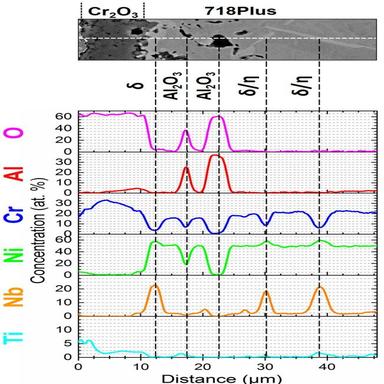
EDXS concentration vs. depth profiles of O, Al, Cr, Ni, Nb and Ti, acquired along the dashed white line marked in the cross-sectional image (SEM-SE) of the 718Plus superalloy after 4000 h of oxidation at 850 °C.